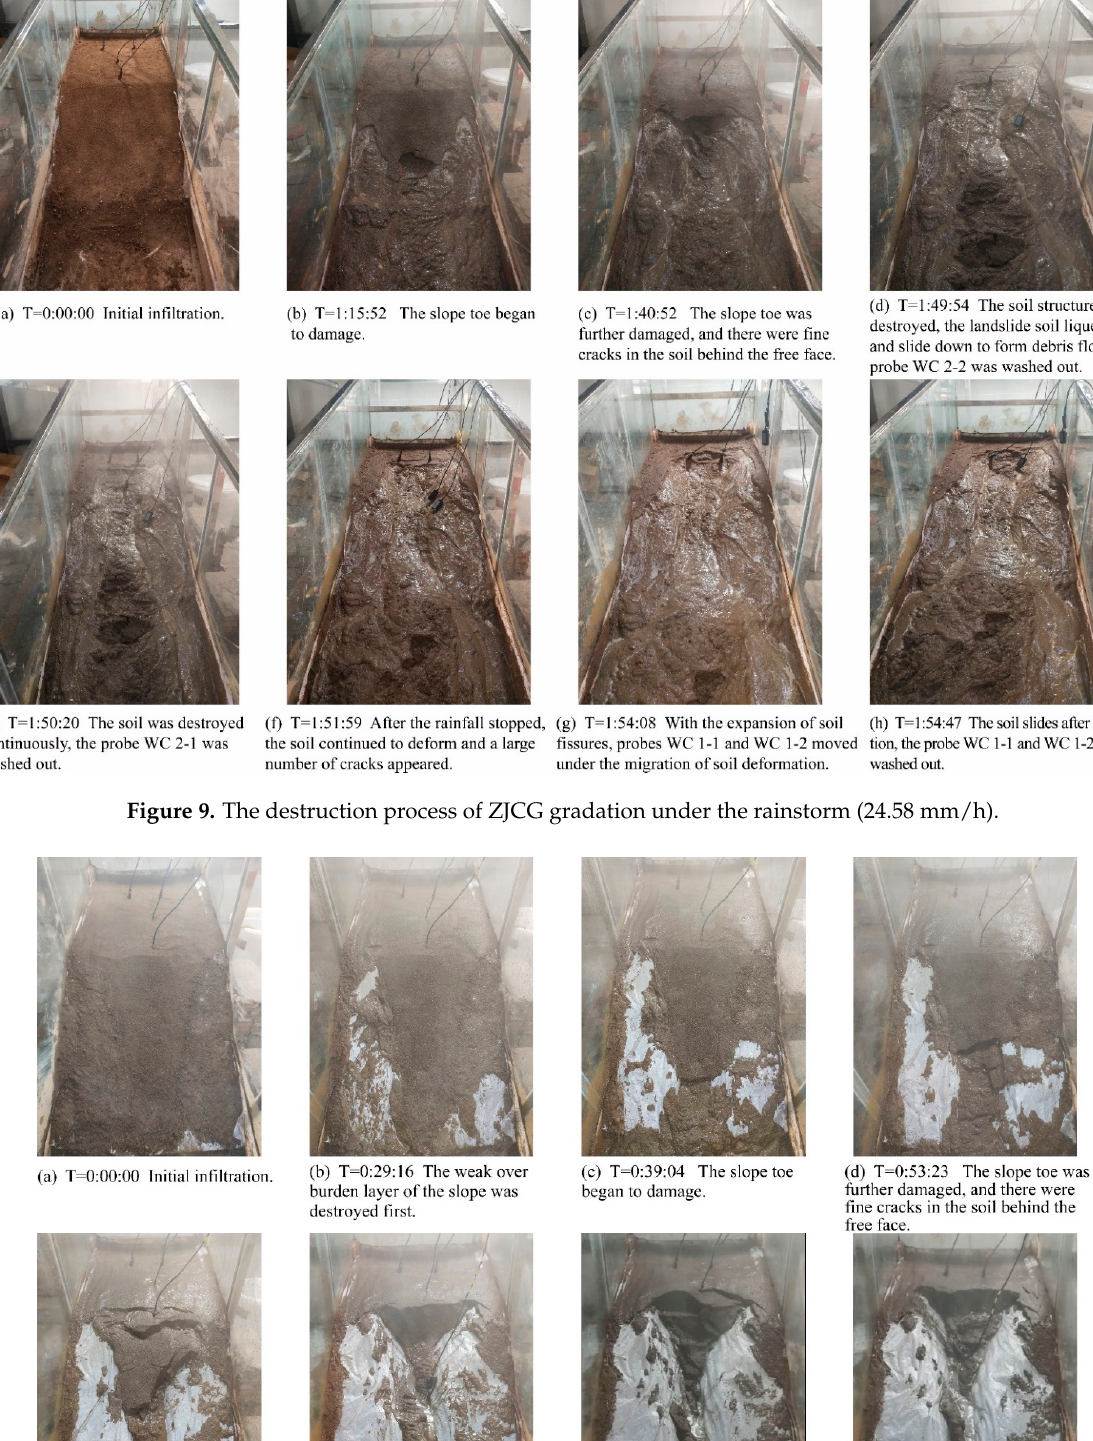
Figure 11. Damage characteristics of ZJCG condition under rare extraordinary rainstorm (109.15 mm/h).